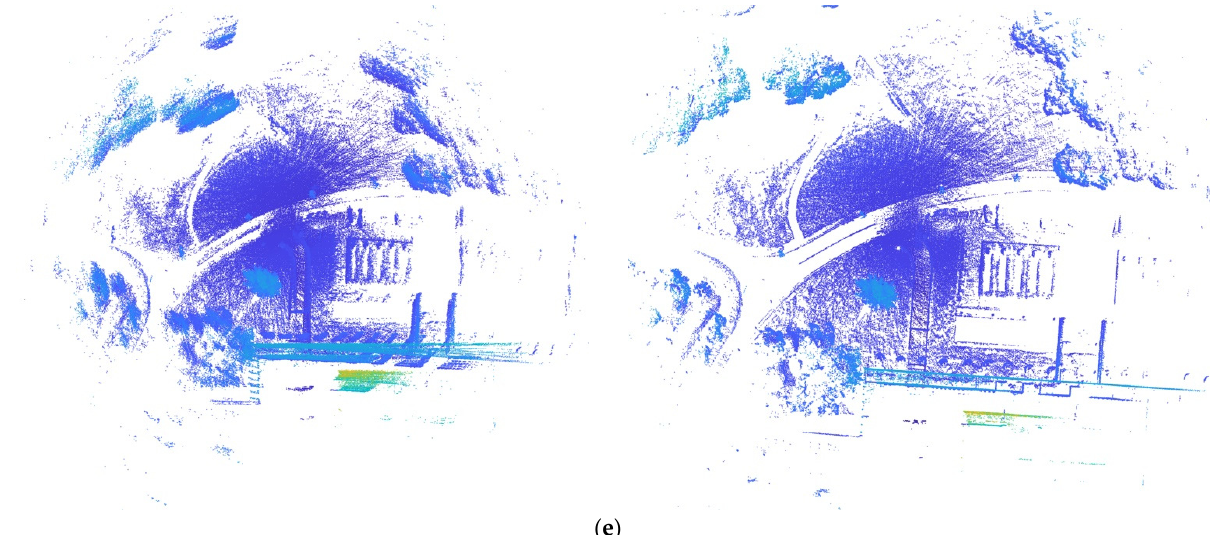
Figure 10. Sequence point cloud registration submaps. The left column shows the submap of ICP in 5 scenes, the right column shows the submap of our method. The 5 rows represent 5 scenes: ( a ) Open indoor; ( b ) Indoor-outdoor scene of an underground passage; ( c ) Indoor narrow corridor; ( d ) Outdoor building; ( e ) Outdoor open scene.